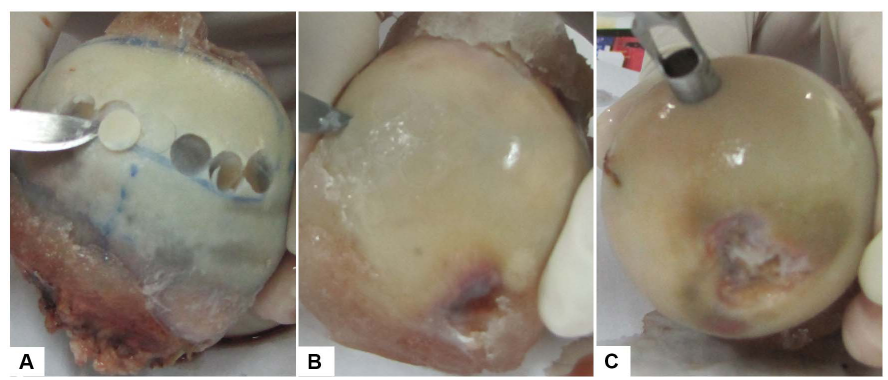
Figure 1. Human femoral heads at different OA stages explanted from total hip replacement operations. (A) normal cartilage, (B) early OA cartilage, and (C) advanced OA cartilage.